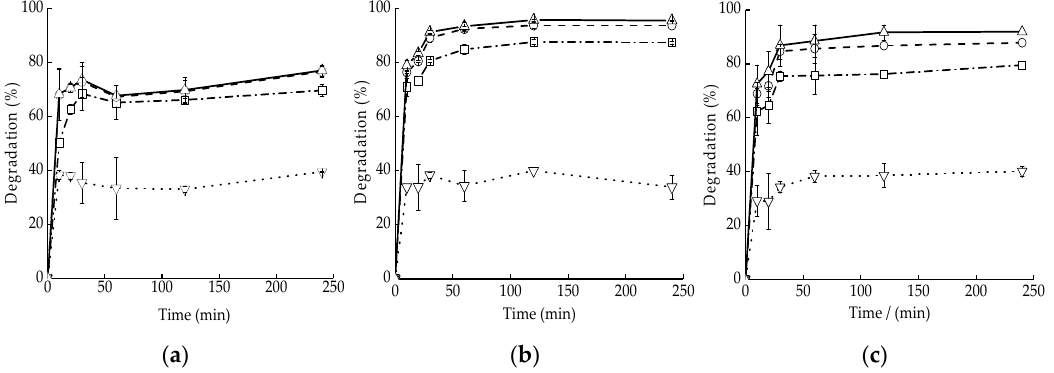
Figure 3. The degradation efficiencies of (-·- □ -·-) PHE, (- - ○ - -) FLU, (— △ —) PYR, and (···· ▽ ····) SDS by ( a ) Fe 2+ , ( b ) nZVI, and ( c ) SiO 2 /nZVI activated persulfate (PS) with time. Values are presented as means and standard deviation.